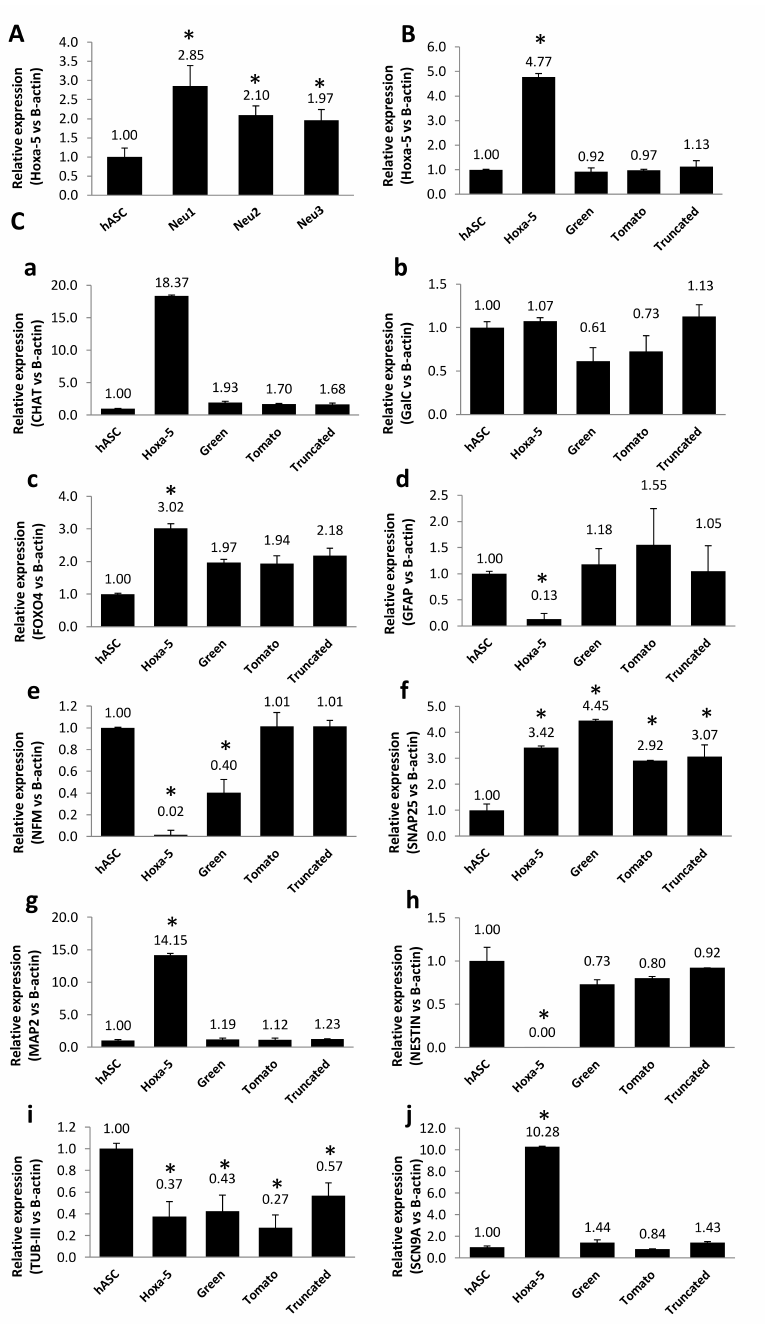
Figure 5. Hoxa-5 expression after hASC exposure to differentiation media (Neu) and hASC transfection. ( A ) Quantitative RT- PCR of Hoxa-5 expression on differentiated hASC cells after Neu 1, 2, and 3 exposure. ( B ) Quantitative RT- PCR of Hoxa-5 expression after the use of a lentiviral system to obtain hASC-Hoxa-5-pLVX-IRES-Zsgreen (Hoxa-5 cells). hASC-Truncated- Hoxa-5-pLVX-IRES-tdTomato (Truncated cells), hASC-pLVX-IRES-Zsgreen (Green cells), and hASC-pLVX-IRES-tdTomato (Tomato cells) (see Section 2). ( C ) Neuronal markers expression ( a : CHAT; b : GalC; c : FOXO4; d : GFAP; e : NFM; f : SNAP25; g : MAP2; h : Nestin; i : TUB-III; j : SCN9A) was analyzed in Hoxa-5, Truncated, Green, and Tomato cells by quantitative RT-PCR. Statistically significant differences (*) with respect to the control ( p ≤